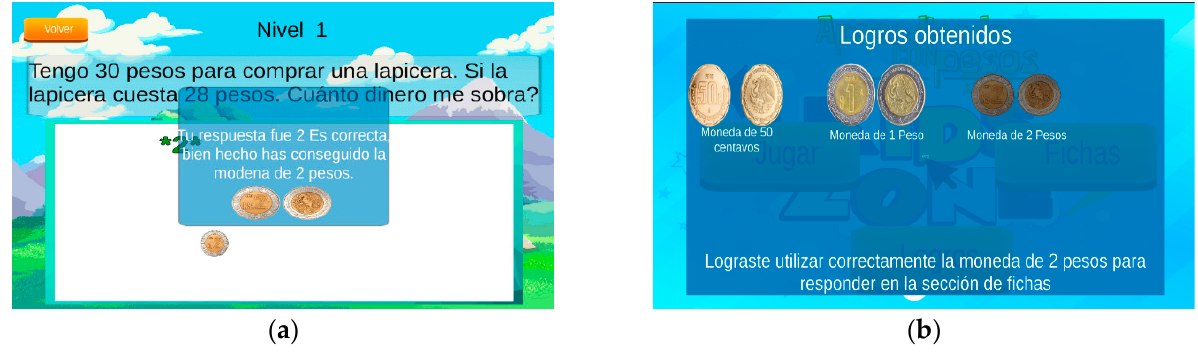
Figure 6. ( a ) Interface of mathematical problems section. ( b ) Achievement interface displaying coins earned and providing a description of the selected item.